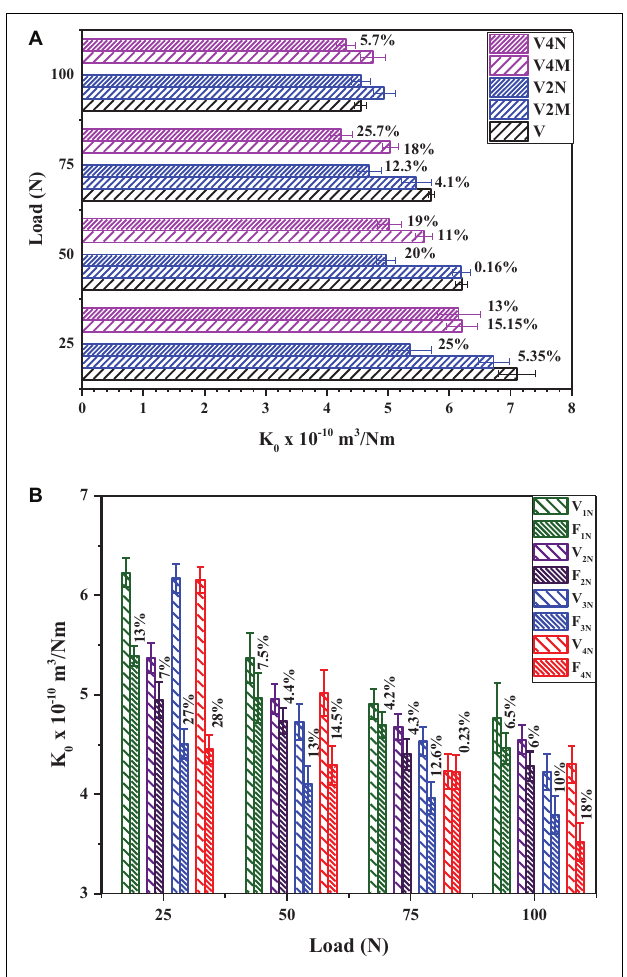
FIGURE 9 | Comparative abrasive wear performance at various loads for (A) nanocomposites (NCs) and microcomposites (MCs) (% indicates the% improvement in wear resistance as compared to neat UHMWPE) and (B) NCs and functionalized nanocomposites (F-NCs) (% indicates the% improvement in wear resistance as compared to non-functionalized